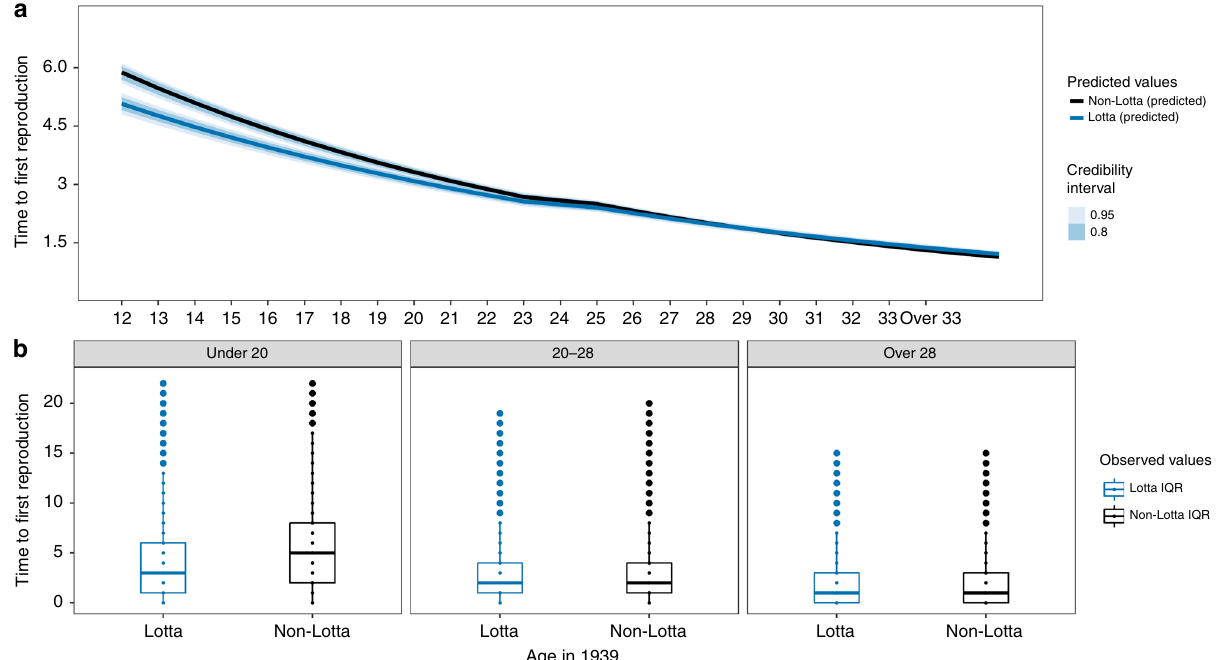
Fig. 1 Younger volunteers of the same age as women who did not volunteer waited less time to give birth after the war ended in 1945. a Model- generated posterior distribution predictions (dark lines), credibility intervals (shaded). b The observed data (median — solid line, box — interquartile range (25% and 75%), whiskers — 5% and 95% intervals) for years to reproduction ( y -axis) for age groups “ Under 20 ” , “ 20 – 28 ” , and “ Over 28 ” when the war began in 1939. See Supplementary Materials: Fig. 1a and Table 1 (top panel, right side) for posterior distributions for all covariates and Supplementary Fig. 3a for posterior predictive check for this model. Differences between the model-generated predictions in panel a and the observed data (panel b ) primarily result from the impact of covariates entered into the